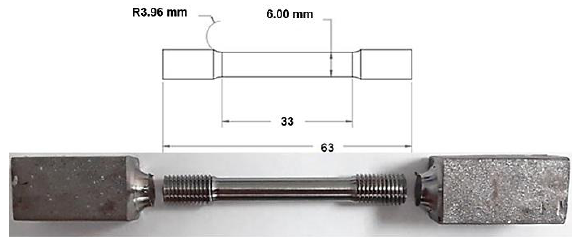
Figure 3. Presentation of the excised tensile specimen from the DPF bar.